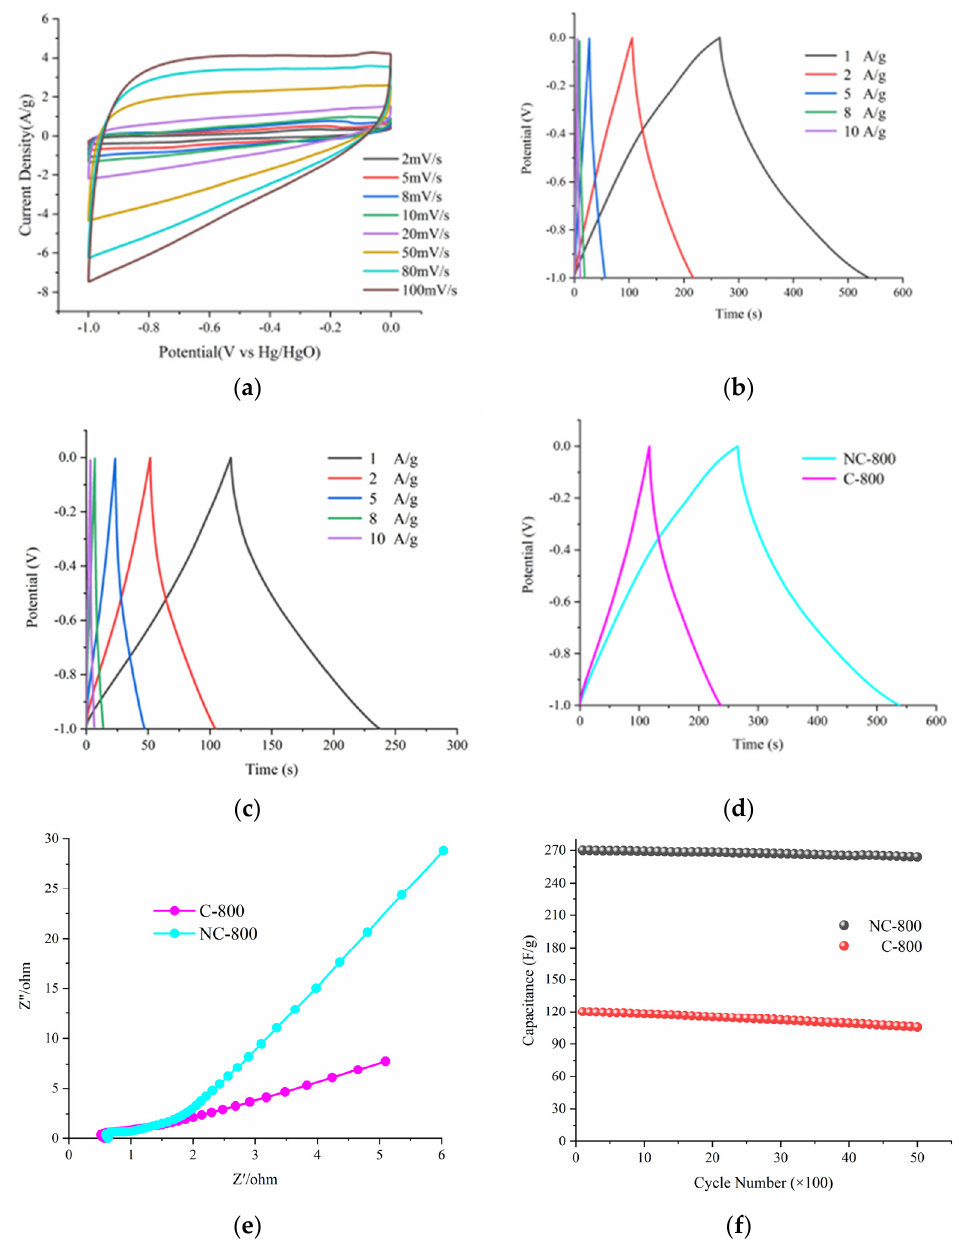
Figure 2. ( a ) CV curves of the NC-800 at different scan rates (2–100 mv/s); ( b ) GCD curves of NC- 800 at different current densities (1–10 A/g); ( c ) GCD curves of C-800 at different current densities (1–10 A/g); ( d ) Comparison of NC-800 and C-800; ( e ) Nyquist plots of NC-800 and C-800; ( f ) Cycling performance of NC-800 and C-800 electrode for 5000 cycles.